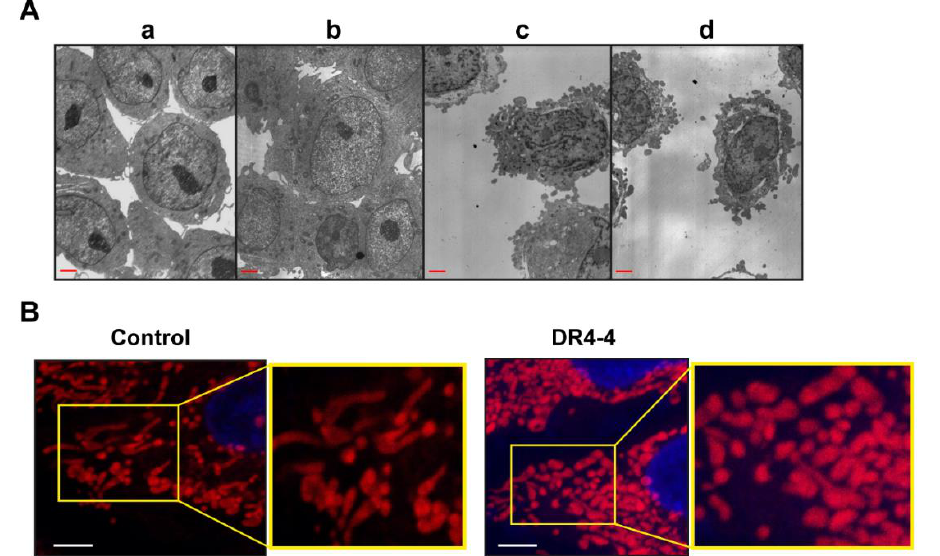
Figure 5. Morphological observation of cells treated with DR4-4 Fab. ( A ) Representative transmission electron microscopy images taken after THP-1 cell treatment with 50 µ g / mL DR4-4 Fab for 0 h ( a ), 24 h ( b ), or 48 h ( c , d ). Scale bar, 2.5 µ m. ( B ) Representative images showing morphological changes in the mitochondrial network of HeLa cells treated with 50 µ g / mL DR4-4 Fab for 24 h observed by confocal microscopy (100 × ) after MitoTracker Red FM staining of mitochondria. Scale bar, 5 µ m. The parts of the images were enlarged and presented in yellow squares.